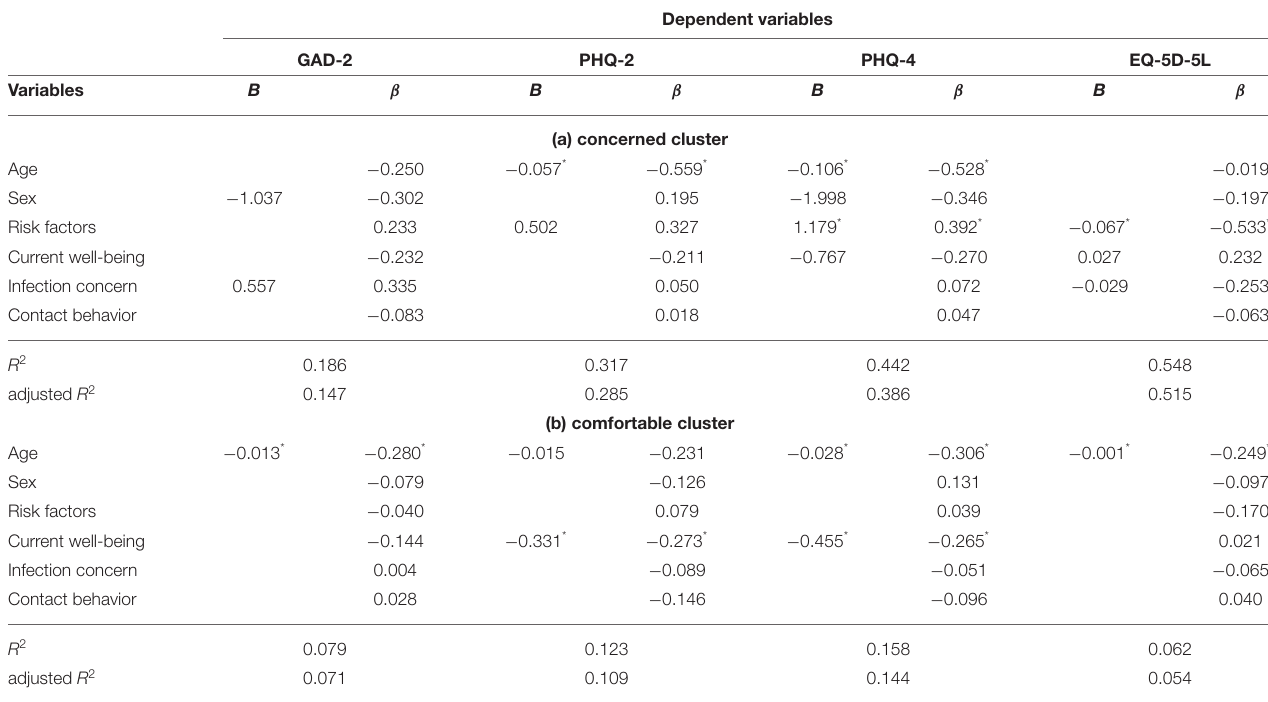
TABLE 3 | Possible predictors for GAD-2, PHQ-2, PHQ-4, and EQ-5D-5L scores, identified by multiple regression models using the forward approach, applied on both clusters concerned (a) and comfortable (b). Dependent variables GAD-2 PHQ-2 PHQ-4